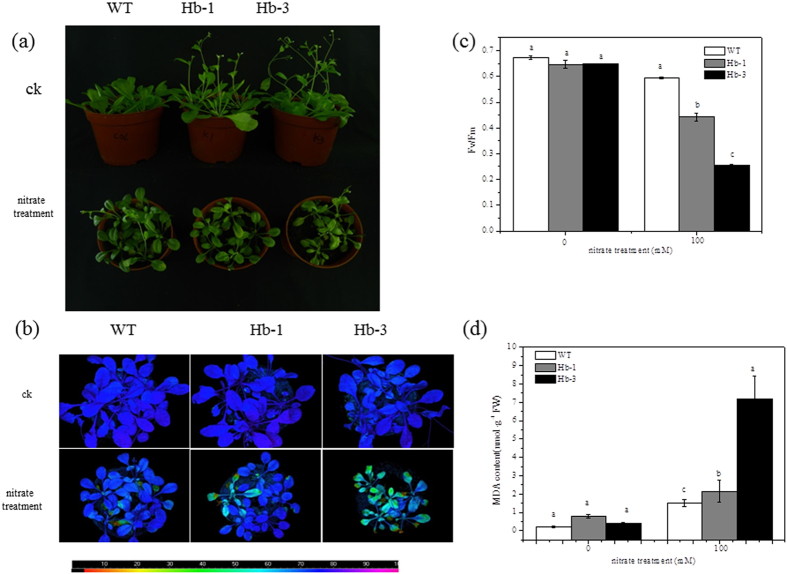
Effects of nitrate stress on the tolerance of adult transgenic seedlings.(a) Morphology of adult plants of transgenic Arabidopsis after nitrate treatment. (b) Images of Fv/Fm (bottom); F0 (top) was used as the control. The pseudocolor code depicted at the bottom of the image ranges from 0 (black) to 1.0 (purple). (c) Average Fv/Fm values. (d) The lipid peroxidation analysis of WT and transgenic plants after nitrate stress treatment. Plants were treated with 100 mM nitrate solution for 15 days. The experiment was replicated three times with similar results. Means denoted by different letters show significant differences at P < 0.05 according to Duncan test.